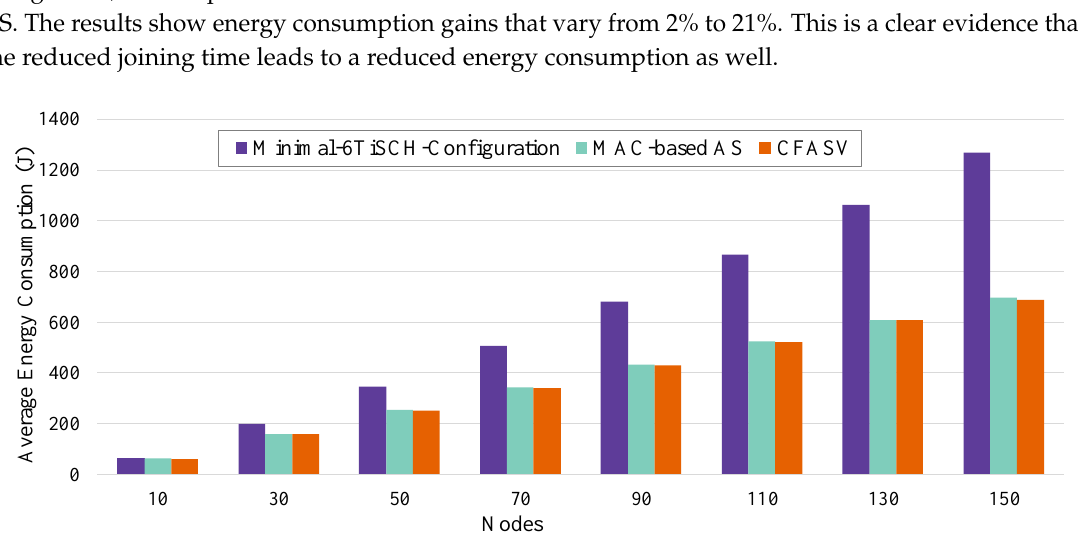
Figure 17. Total energy consumption until all the nodes connect to the network for a scenario where the PAN coordinator has limited power resources.